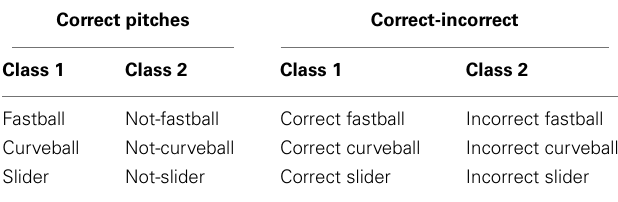
Table 2 | Definition of classes used in discrimination